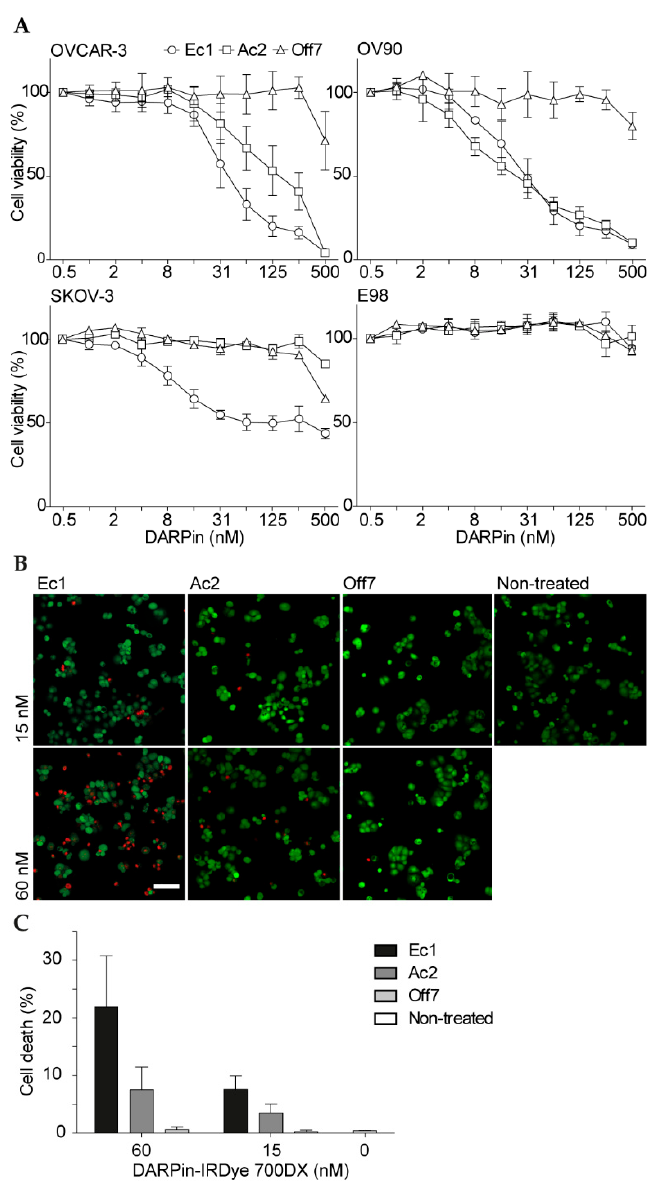
Figure 3. Cell viability after DARPin-IRDye 700DX incubation and illumination. ( A ) Cell viability in monolayers of OVCAR-3, OV90, SKOV-3 and E98 cells. Cells were incubated with different concentrations of DARPin-IRDye 700DX conjugates for 2 h followed by illumination (60 J/cm 2 at 100 mW/cm 2 ). After overnight incubation, cell viability was determined with a resazurin cell viability assay. Mean and s.e.m. are shown; n = 3 for OV90 and OVCAR-3 cells, n = 2 for SKOV-3 and E98 cells. The scale on the x -axis is logarithmic. ( B ) Confocal microscopy imaging of cell viability in OVCAR-3 cells after 30 min incubation with 15 or 60 nM DARPin-IRDye 700DX conjugates and illumination (60 J/cm 2 at 100 mW/cm 2 ). Representative microscopy images of cell death after PDT are shown. Red indicates propidium iodide, green indicates calcein. Scale bar represents 100 µm. ( C ) Quantification of cell death using a macro in ImageJ. For each experiment, 12–20 images were analyzed per condition; mean is shown; error bar represents the range of independently performed experiments ( n = 2).